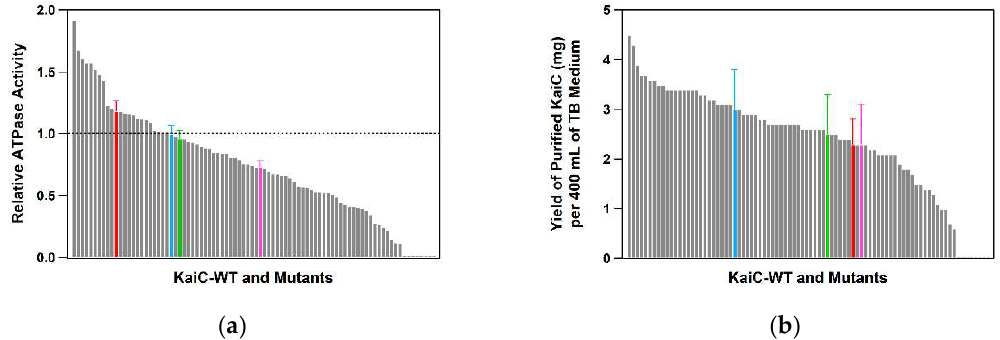
Figure 3. Preliminary dataset for 86 KaiC mutants. ( a ) Distribution of the relative ATPase activities. ( b ) Distribution of the final yields (per 400 mL of terrific broth medium) of His-tagged KaiC. Mean values for KaiC-WT, KaiC-P37A, KaiC-T228A, and KaiC-C306A are represented as blue, green, magenta, and red bars, respectively, with standard deviation from three independent experiments. Table 1. Temperature dependency of ATPase activity of KaiC, period length of in vitro post-translational oscillations (PTO), and period length of in vivo transcriptional and translational oscillations (TTO).